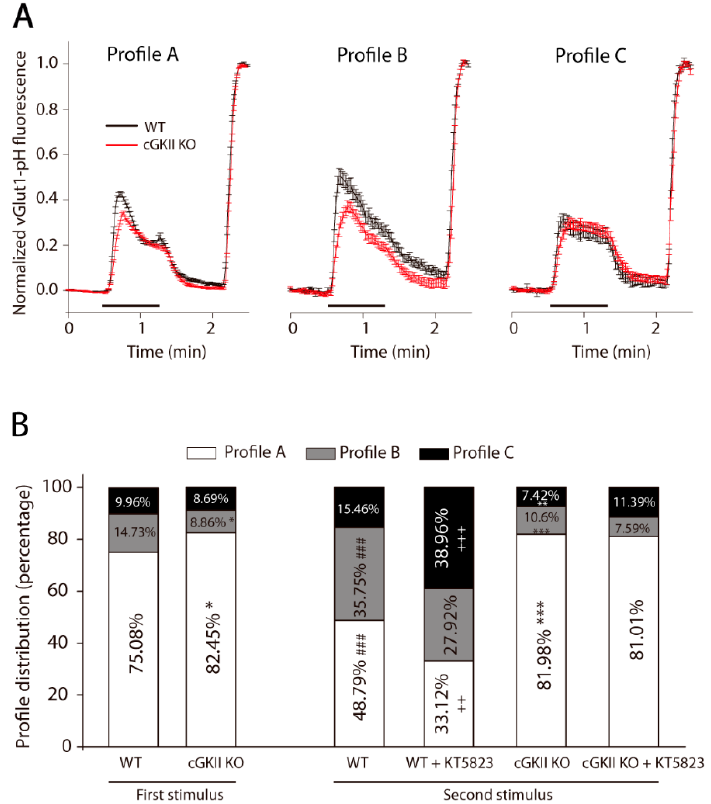
Figure 7. Heterogeneous profiles for vGlut1-phluorin fluorescence recovery after strong and sustained stimulation (50 s, 50 mM KCl) in synaptic terminals from WT or cGKII KO cells. ( A ) Profile A: Mean traces of KCl-elicited vGluT1-phluorin fluorescence normalized to NH 4 Cl-elicited fluorescence in WT ( n = 159 boutons) and cGKII KO neurons ( n = 235 boutons). Profile B: Mean traces of KCl-elicited vGluT1-phluorin fluorescence normalized to NH 4 Cl-elicited fluorescence in WT ( n = 37 boutons) and cGKII KO neurons ( n = 20 boutons). Profile C: Mean traces of KCl-elicited vGlut1-phluorin fluorescence normalized to NH 4 Cl-elicited fluorescence in WT ( n = 18 boutons) and cGKII KO neurons ( n = 28 boutons); ( B ) Proportions of the three types of profiles found in WT and cGKII KO cells in response to the first stimulus (WT n = 4 coverslips and cGKII KO n = 5 coverslips from three cultures; * p = 0.04) or the second stimulus ± KT5823 (WT n = 4 coverslips and cGKII KO n = 4 coverslips from three cultures). ### p = 0.0005 (WT 2nd vs. 1st stimulus). ++ p = 0.0022, +++ p < 0.0001 (WT 2nd stimulus ± KT5823). ** p = 0.0001, *** p < 0.0001 (cGKII KO 2nd stimulus vs. WT 2nd stimulus). The